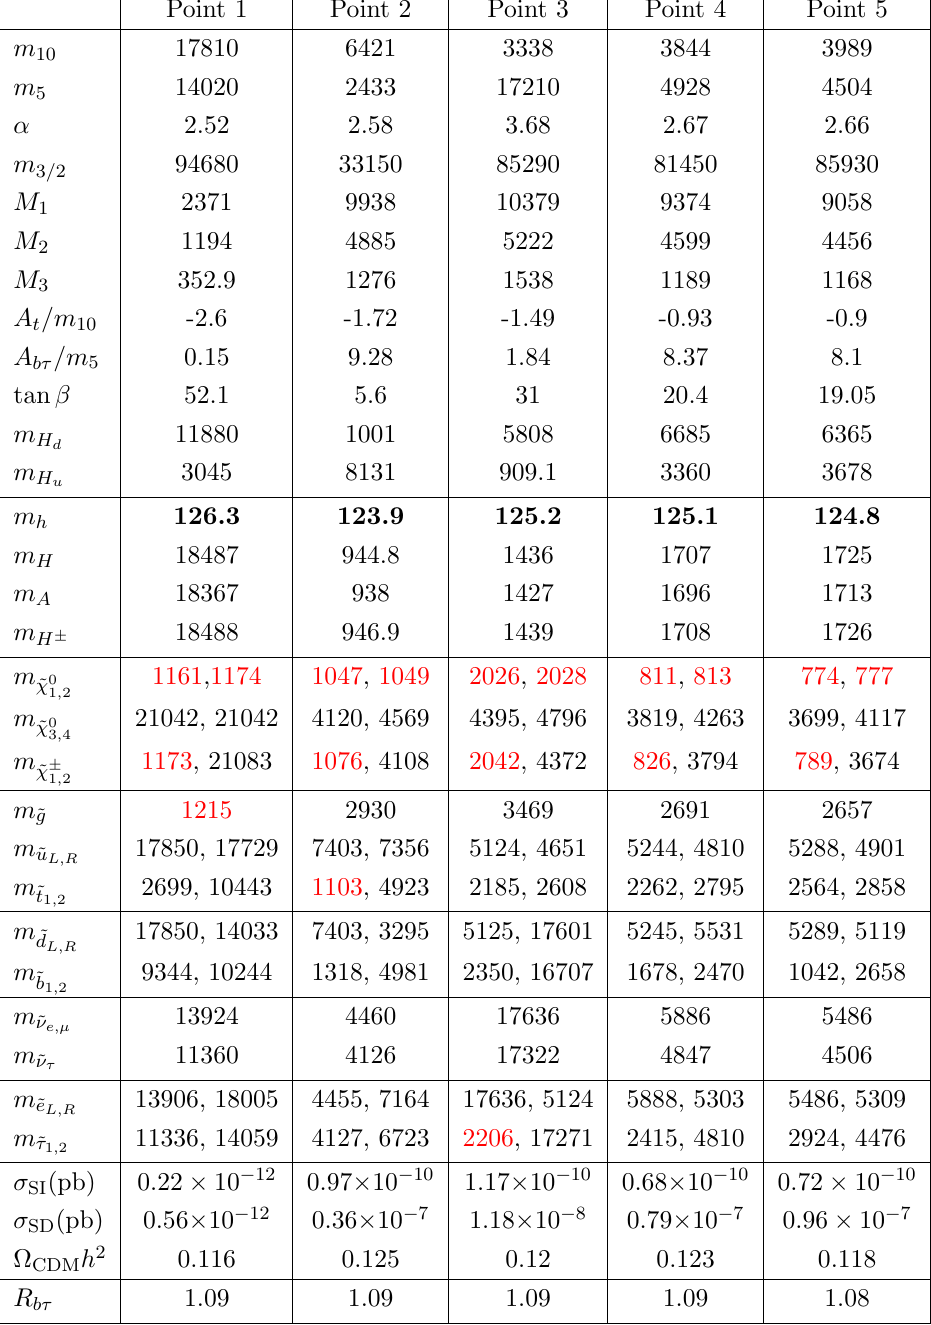
Table 1 . All points are consistent with the experimental constraints given in section 3 and the b (cid:0) (cid:28) YU condition. All masses are given in GeV. Point 1 displays a solution for the